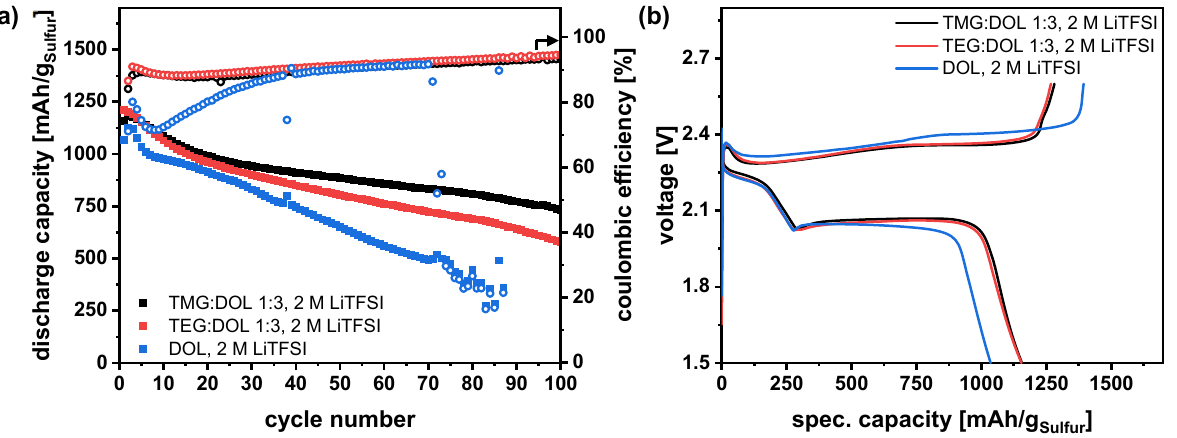
Figure 4. Galvanostatic cycling at 0.1 C and 25 °C of adapted glyoxal electrolytes, TXG:DOL 1:3 with 2 M LiTFSI and DOL-reference with 2 M LiTFSI, ( a ) cycle life, ( b ) voltage profiles of 5th cycle tested in coin cells.